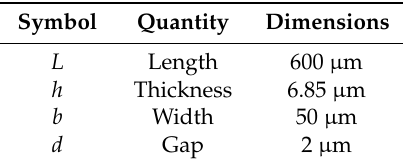
Table 1. The geometrical properties of the microbeam.